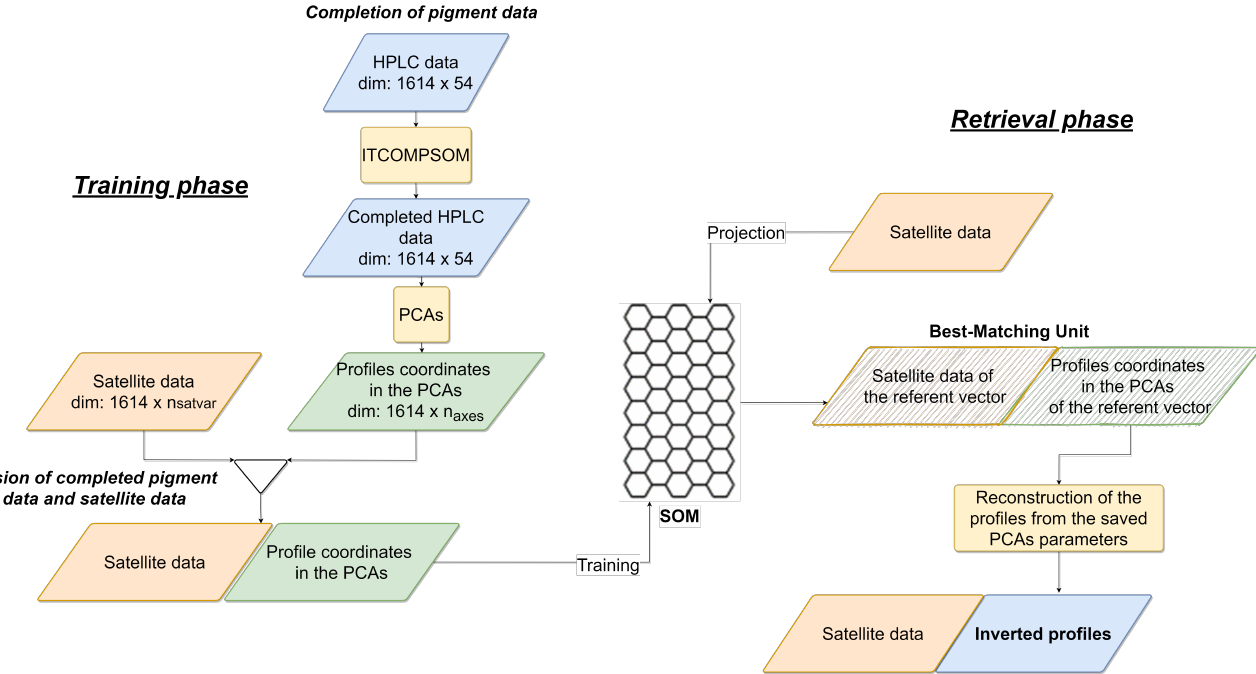
Figure 2. Flow diagram of the Sat2Profile . A 500-fold cross-validation was effectuated on the training data. In our study, the different phases were implemented in the way presented